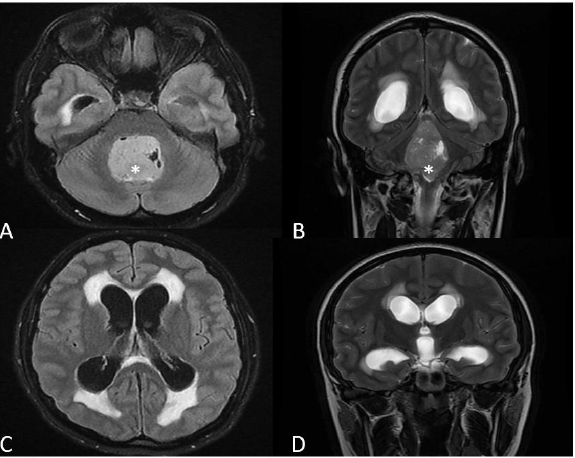
Figure 1. MRI scan, axial section, FLAIR sequence ( A ) and coronal section, T2 sequence ( B ), showing a large intraventricular tumor, located in the 4th ventricle . Enlargement of the lateral and third ventricles and transependimar resorption ( C , D ).